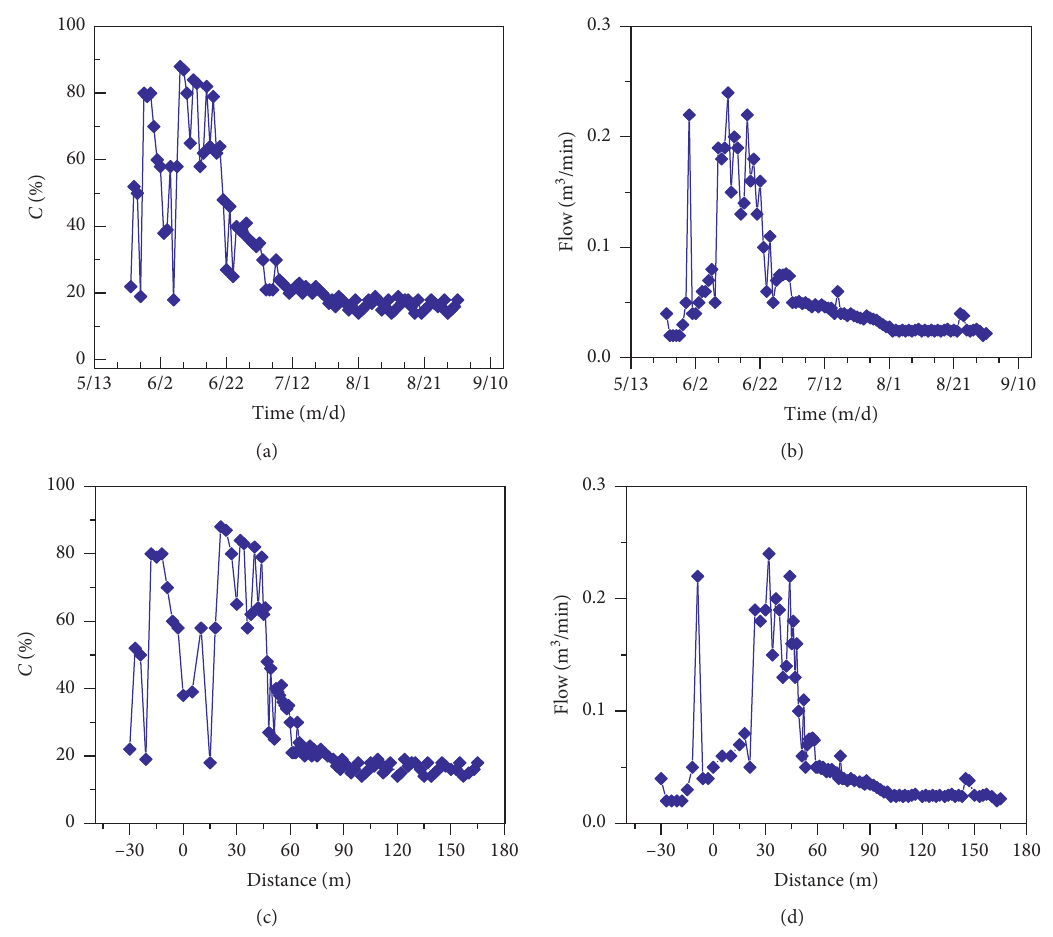
Figure 8: Gas monitoring data in no. 1 borehole of group